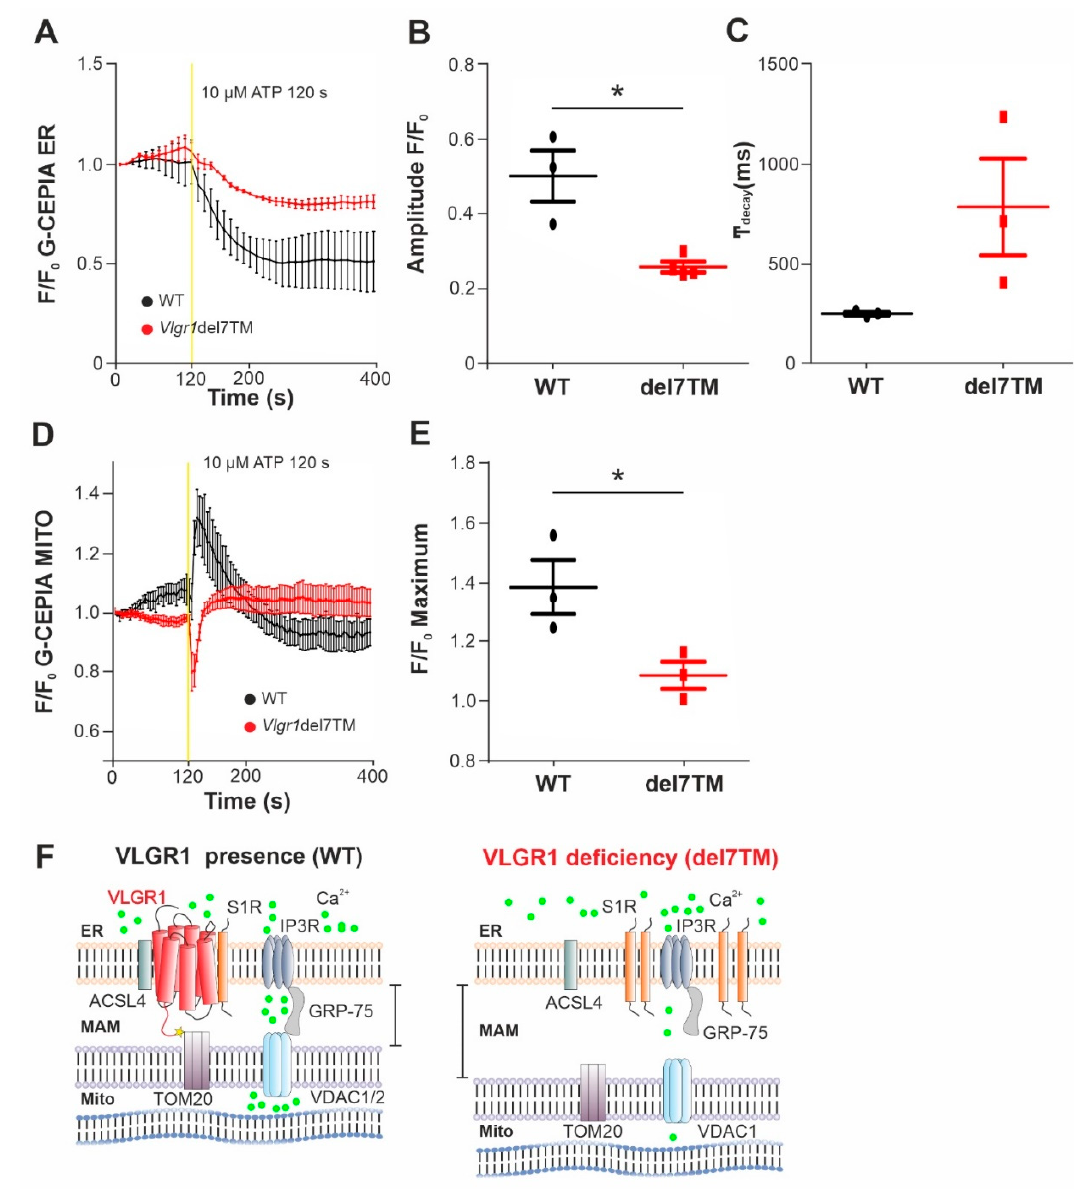
Figure 5. VLGR1 deficiency decreases the Ca 2+ release from ER and uptake to mitochondria in astrocytes. ( A ) Averaged time-course of the ER Ca 2+ signal in response to ATP stimulation at 120 s, monitored by G-CEPIA1er, in WT control (black) and Vlgr1 del7TM (red) astrocytes. ( B ) Quantification of G-CEPIA1er signal amplitude, p = 0.0056. WT: n = 3 individual experiments; Vlgr1 del7TM: n = 3 individual experiments. ( C ) Quantification of time constant ( τ ) of the G-CEPIA1er signal decay (fitting by single exponential function), p = 0.2814. ( D ) Mitochondrial Ca 2+ signals were measured using CEPIA2mt after stimulation with ATP at 120 s in WT control and Vlgr1 del7TM astrocytes. ( E ) Amplitude of signals for mitochondrial Ca 2+ response after ATP stimulus; p = 0.0438. WT: n = 3 individual experiments; Vlgr1 del7TM: n = 4 individual experiments. Yellow line indicates application of 10 µ M ATP at 120 s. Error bars represent SEM. Student’s t-test for statistical significance: * p <